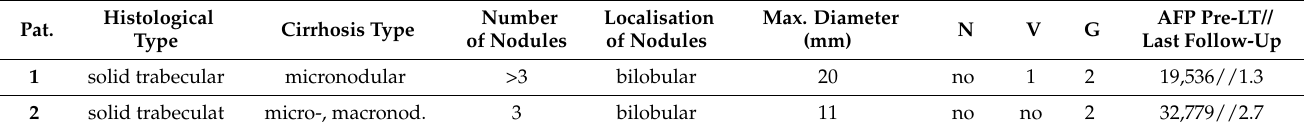
Table 2. HCC characteristics.